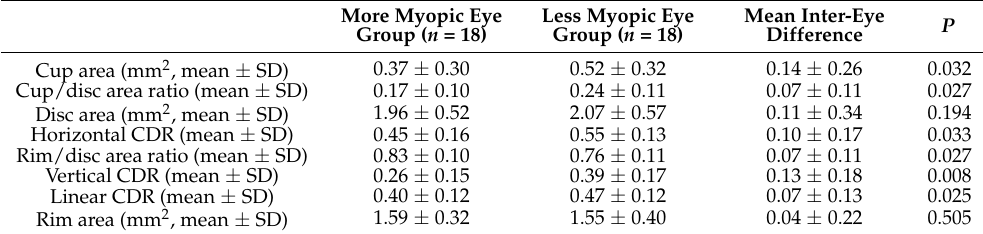
Table 2. Inter-eye comparisons of ONH parameters (paired t